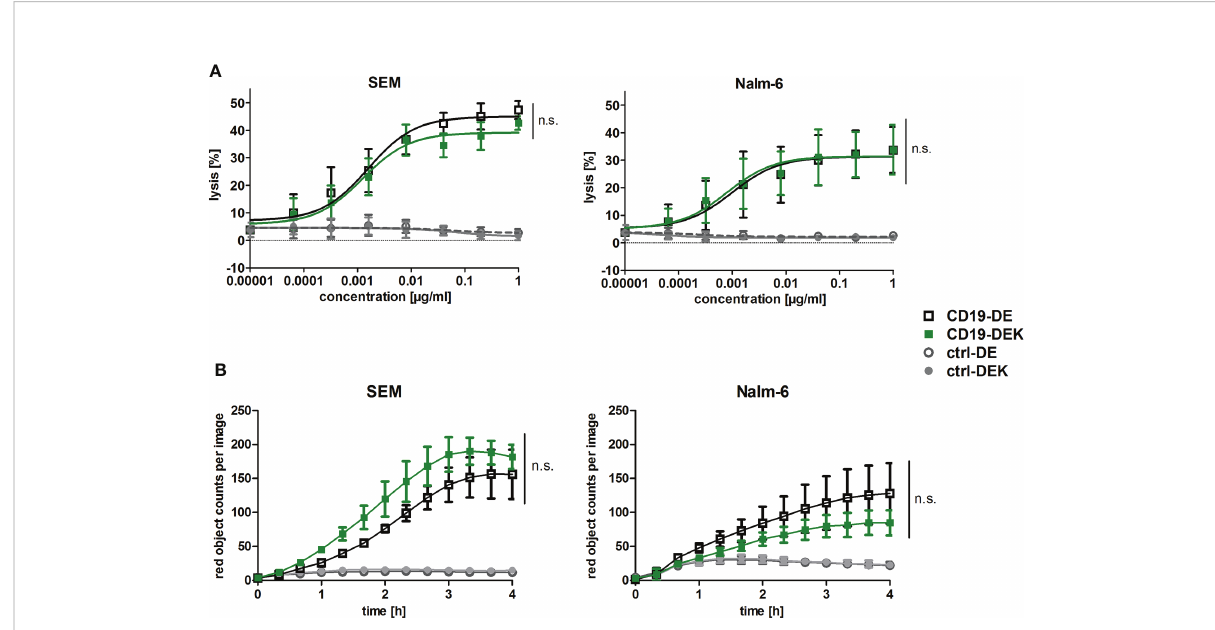
FIGURE 2 The dual Fc-optimized antibody CD19-DEK triggers Fc g R-mediated effector functions comparable to CD19-DE. (A) Chromium release assays were performed to analyze ADCC. CD19-positive tumor cell lines SEM and Nalm-6 were used as target cells and PBMC of healthy donors at an Effector : Target (E:T) ratio of 40:1 were applied. The tumor cell lysis triggered by CD19-DEK and CD19-DE was compared to control antibodies (ctrl-DEK and ctrl-DE). (B) The antibody-dependent cell-mediated phagocytosis (ADCP) was measured for 4 h by high-throughput fl uorescence microscopy. CD19-positive cell lines were labelled with a pH-sensitive red- fl uorescent dye and were incubated at an E:T ratio of 1:1 with polarized M0 macrophages and 10 µg/ml of the indicated antibodies. Phagocytosis is depicted as the relative red object counts per image. Data represent mean values ± SEM of three independent experiments, * P <0.05%, ns, not signi fi cant. CD19-DEK vs. CD19-DE, Two-way ANOVA with Bonferroni